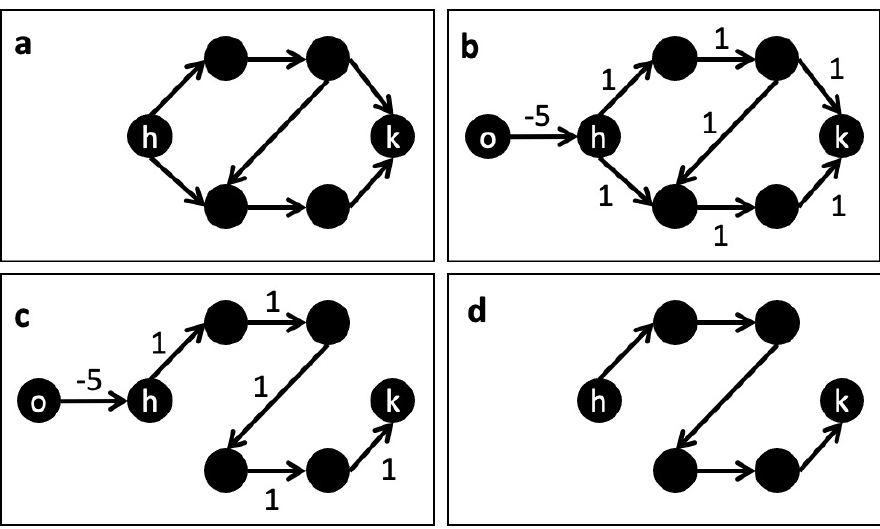
Figure 1. ( a ) An example of a graph G . ( b ) Graph G (cid:48) derived from G . ( c ) A solution of CBPP with cost zero. ( d ) The Hamiltonian